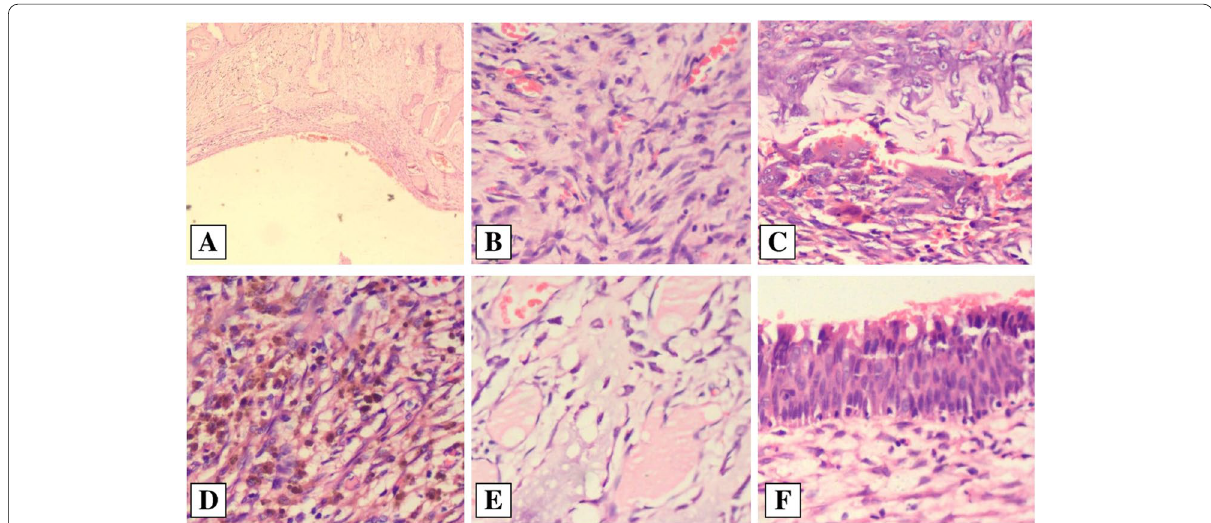
Fig. 2 Histopathological examination findings. A Dilated vascular spaces without endothelial lining. B Fibroblastic stroma consisting of plump fibroblast and multiple capillaries. C Scattered osteoclasts-like giant cells noted in stroma. D Siderophages in stroma. E Reactive woven bone in stroma. F Respiratory epithelium. (Hematoxylin & eosin staining;